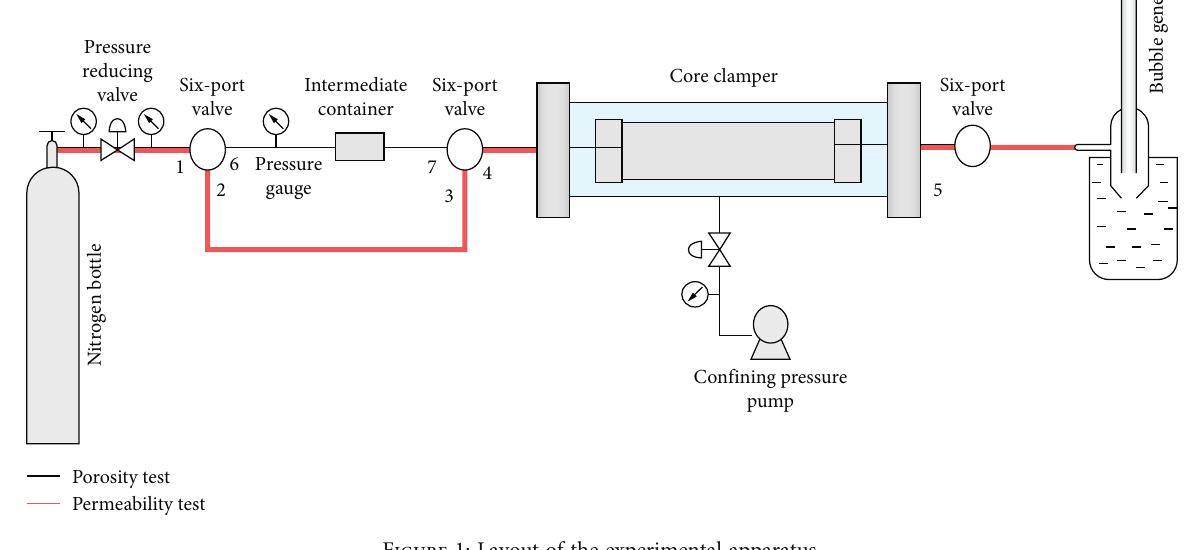
Figure 1: Layout of the experimental apparatus.